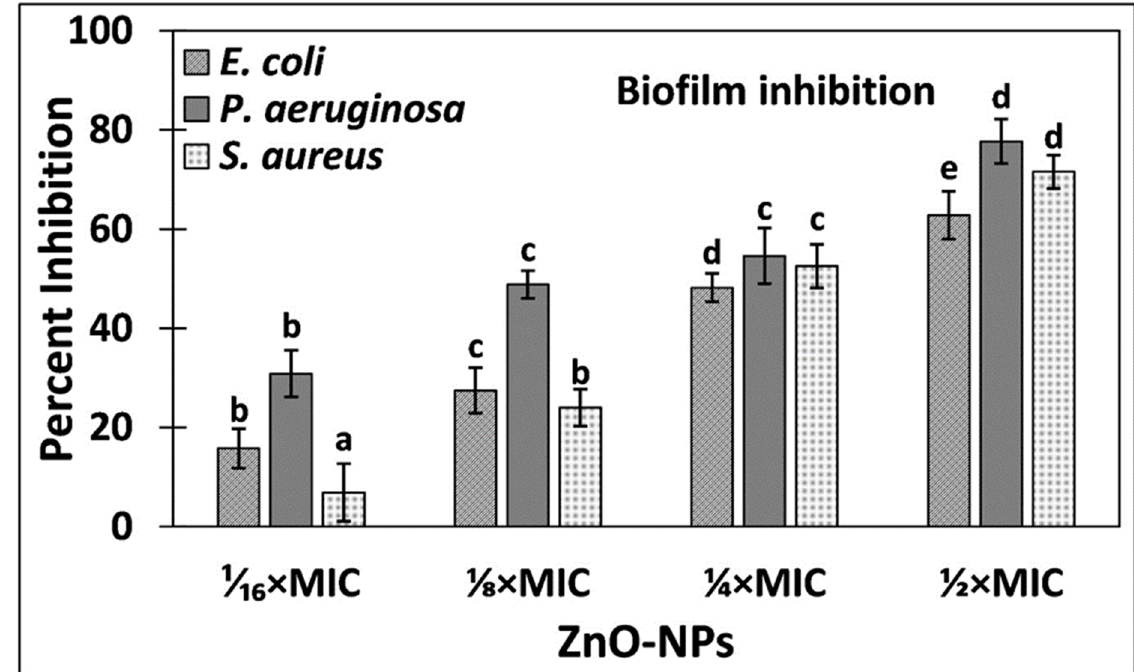
Figure 3. Inhibition of biofilm formation of E. coli , P. aeruginosa , and S. aureus by ZnO-NPs. Data is presented as average of three replicates and error bar is standard deviation. One-way ANOVA was performed using Tukey test at significance level of 0.05. Different letters in treatment groups represent different significance groups at p -value = 0.05 and are in ascending/descending order of values starting from the letter “a”.